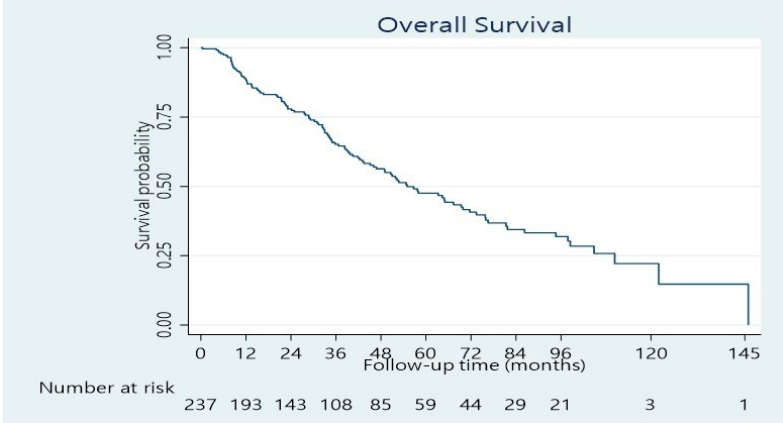
Figure 1. Overall survival distribution of patients resected for HCC.